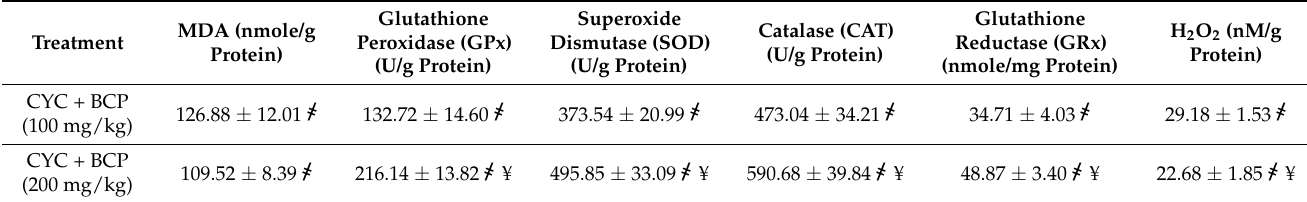
Table 1. Effects of treatment with β -caryophyllene (BCP) for 14 days on cyclophosphamide (CYC) induced fluctuations in body and heart weights and heart to body weights ratio in rat.